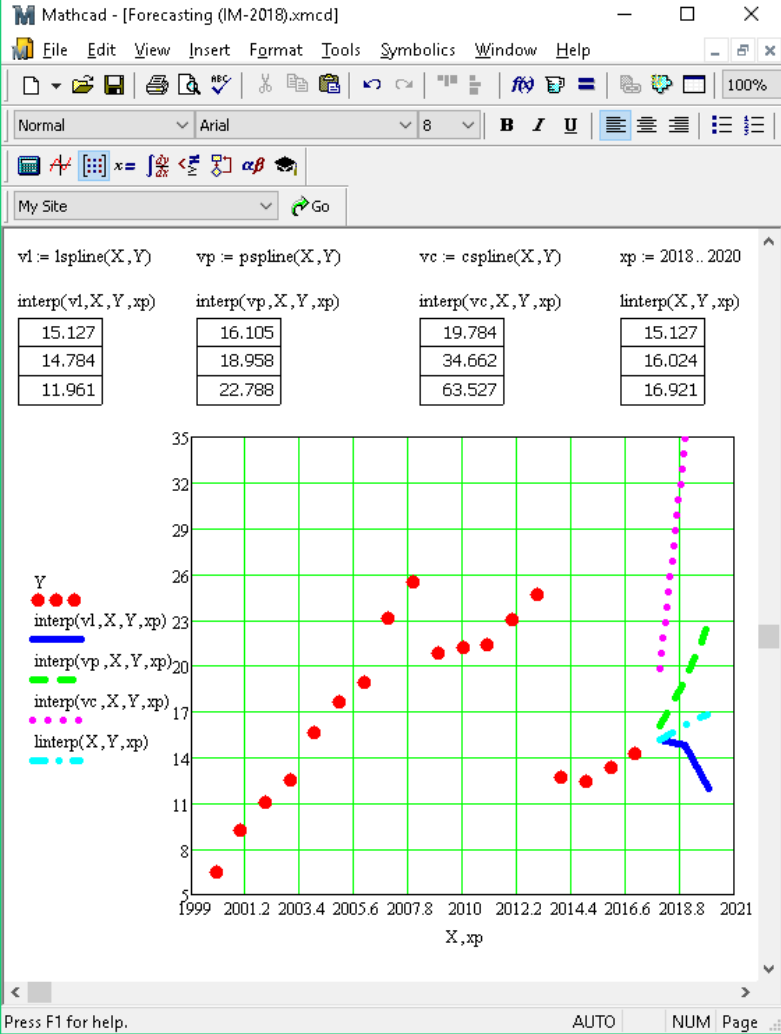
Figure 5. Building the forecasting models by spline interpolation in